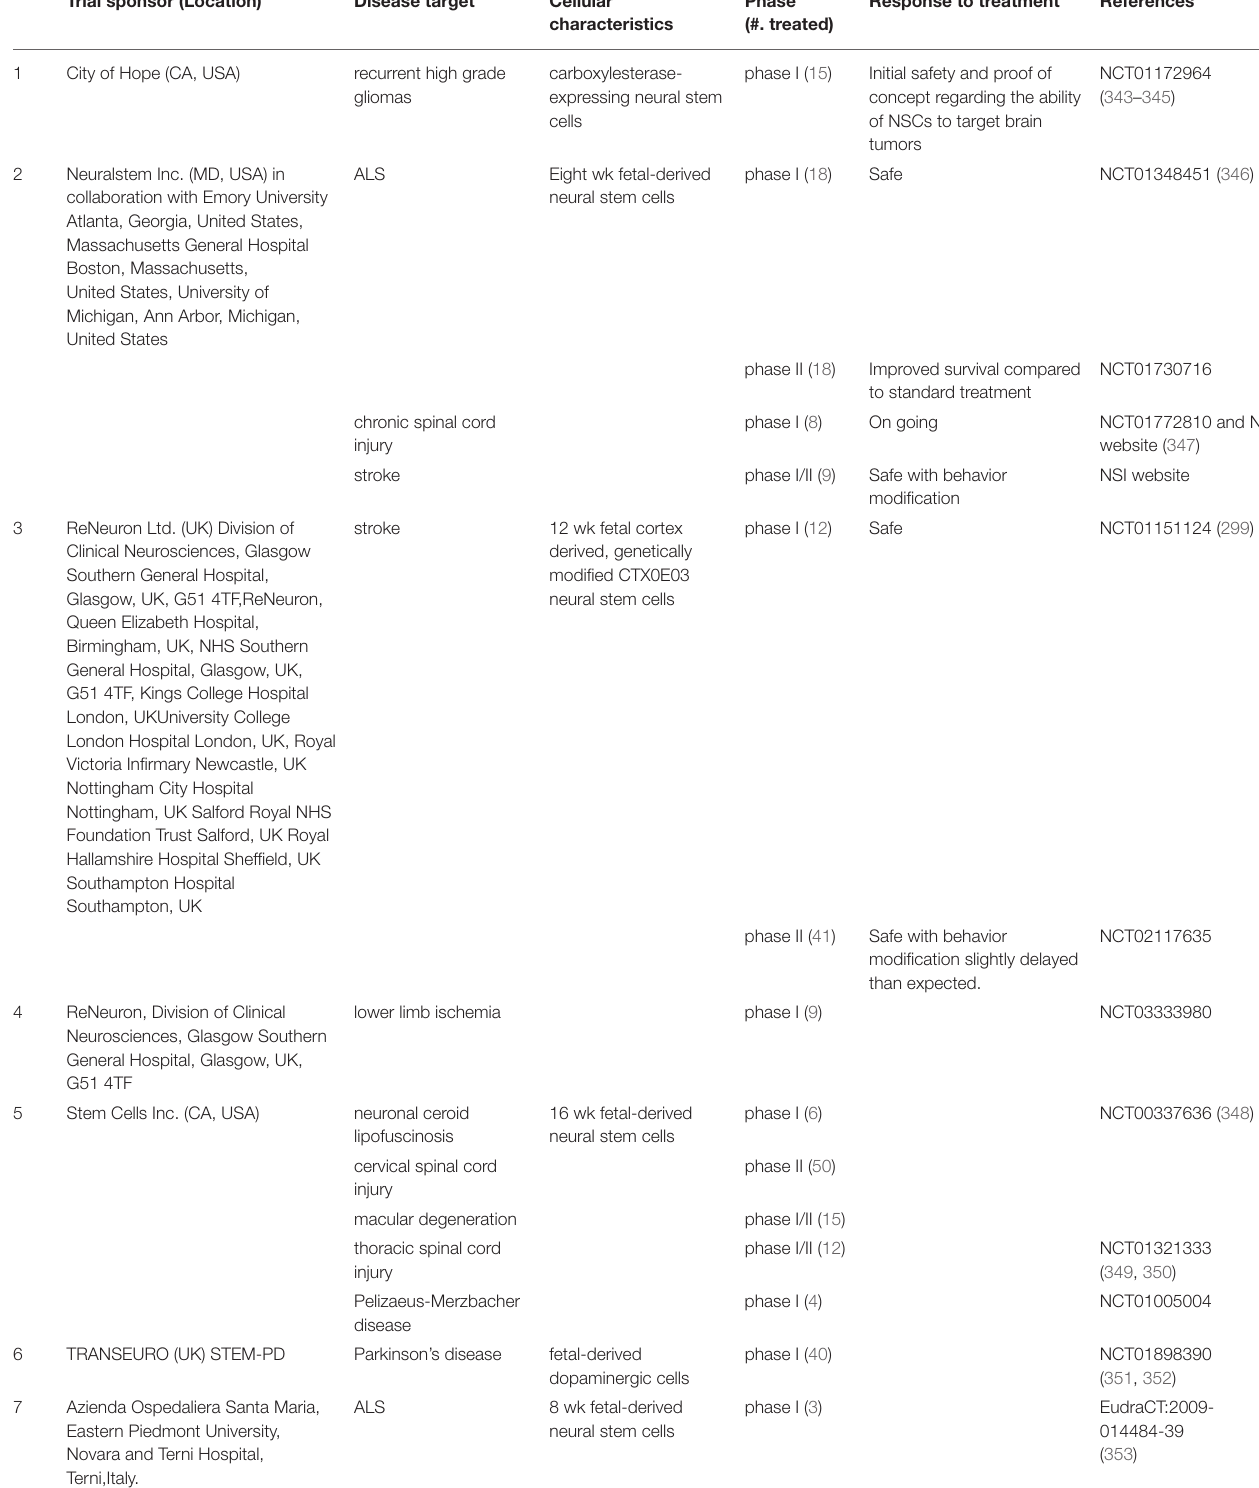
TABLE 2 | Human fetal neural stem cells in Clinical